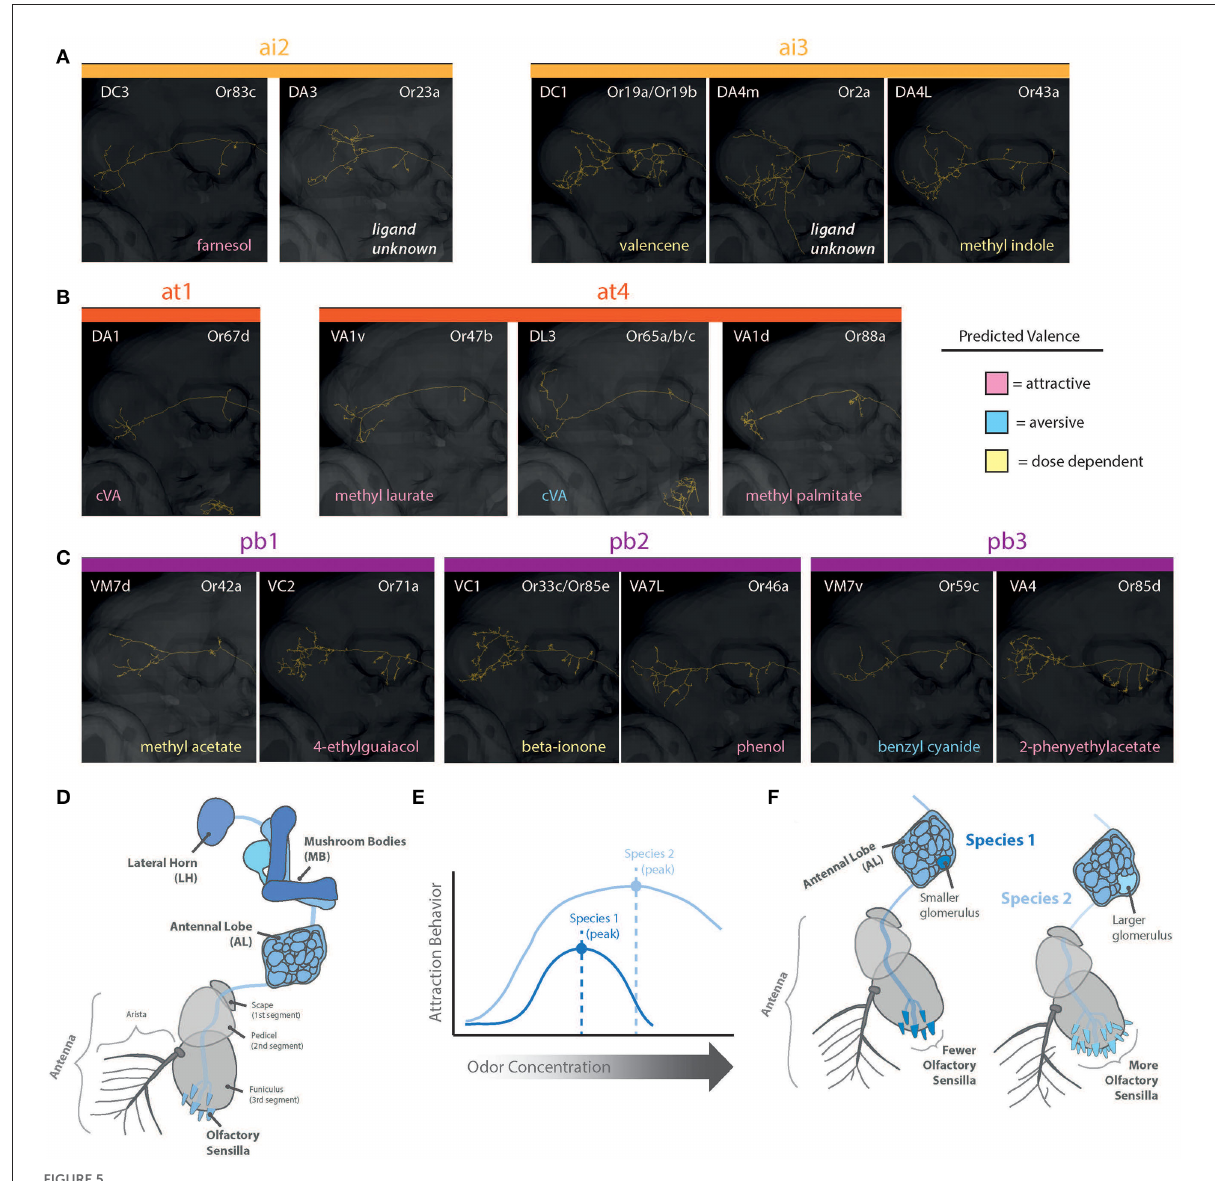
FIGURE5 Reconstructions of PNs for olfaction (intermediate, trichoid, and palp sensilla). Shown are pathways through MB and into LH. (A) Projection neurons (PNs) from antennal intermediate sensilla (ai1 and ai3) and predicted behavioral valence as well as strongest excitatory odorant/ligand. (B) Projection neurons (PNs) from antennal trichoid sensilla (at1 and at4) and predicted behavioral valence as well as strongest excitatory odorant/ligand. (C) Projection neurons (PNs) from palp basiconic sensilla (pb1-pb3) and predicted behavioral valence as well as strongest excitatory odorant/ligand. (D) Olfaction (blue) is primarily from antenna and maxillary palps (shown are antennal pathways), where chemicals are detected within sensillum types, and these neurons then map into the brain of the fly. Primary olfactory processing is within the AL, and then subsequently within the MB and LH (i.e., the higher brain centers). (E) Species can differ in sensitivity and behaviors toward concentrations of the same detected odorant. (F) Species vary in the abundance of each sensillum type. Larger numbers of a sensillum type correlate with a larger corresponding glomerulus volume for those odorants within the AL. AL, antennal lobe; OL, optic lobe; MB, mushroom body; LH, lateral horn; PN, projection